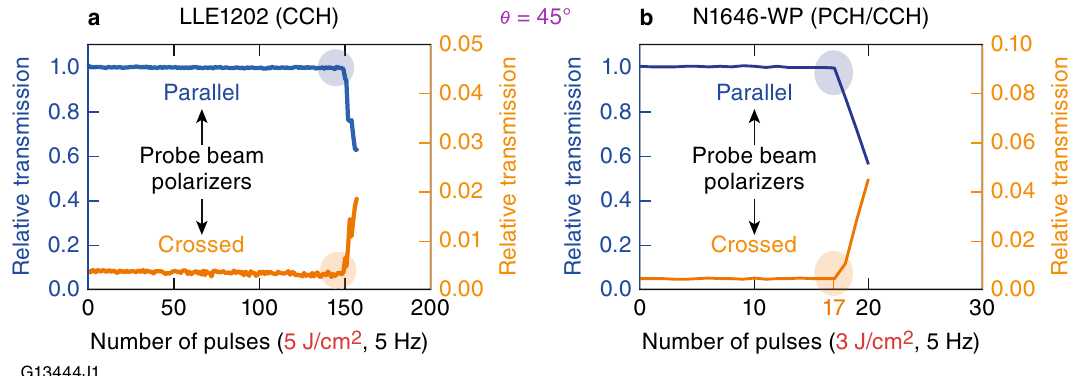
Figure 7. Multipulse LIFT damage testing data for ( a ) LLE1202 and ( b ) N1646-WP at 351 nm, 1 ns with a 5-Hz pulse repetition rate. The blue- and orange-shaded circles indicate the LIFT for each material composition and testing